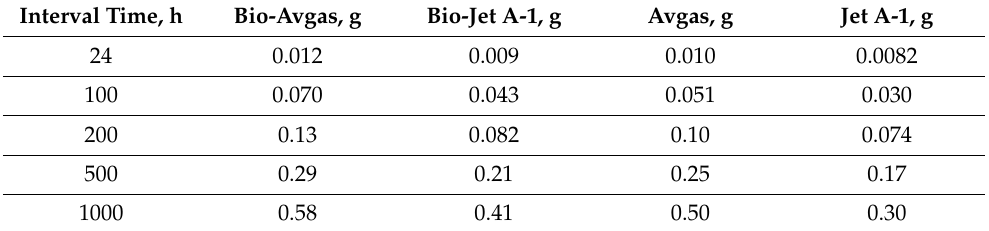
Table 5. Fuels weight reduction during the tests (in grams) for the AFO gasket.